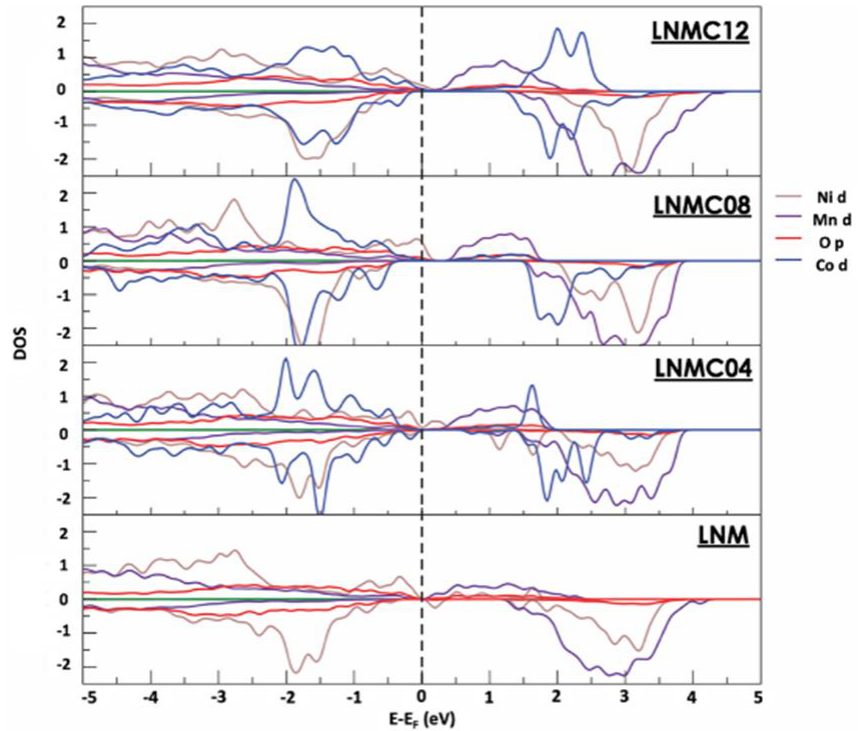
Figure 4. Atomic orbital projected density of states of LNMC12 (upper panel), LNMC08 (upper/middle panel), LNMC04 (middle/bottom panel), which presents a 0-bangap, and LNM (bottom panel).